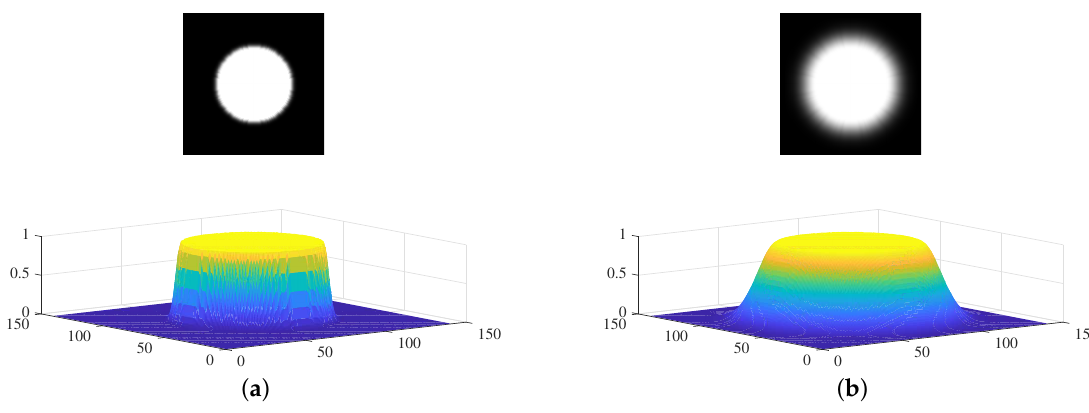
Figure 3. The sensor uncertainty kernels used for visibility convolution: ( a ) A convolution kernel with small sensor errors at the maximum range grid cells. ( b ) A convolution kernel with large sensor errors at the maximum range grid